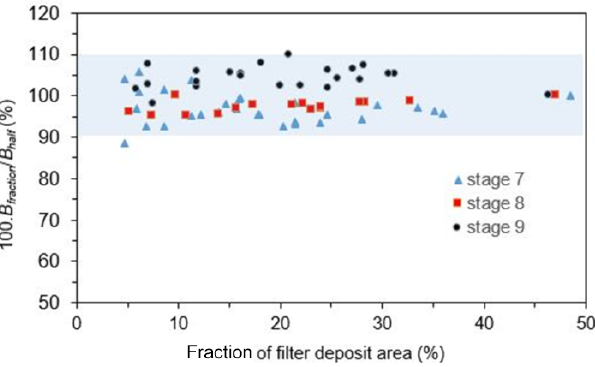
Figure 2. Comparison of mean brightness values for smaller abla- tion areas ( B fraction ) to the half-filter value ( B half ) for Pb in sam- ple 1 (stages 7–9). The blue bar shows that ablation of smaller areas agreed with the half-filter value to ±